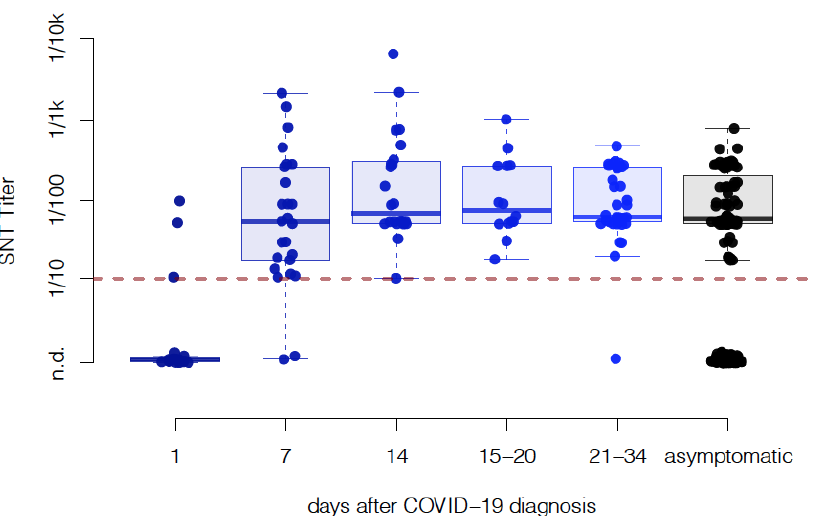
Figure 2. Serum neutralizing antibody titers of mildly symptomatic and asymptomatic individuals. Neutralizing titers of patients with non-severe COVID-19 and asymptomatically infected individuals were measured in quadruplicate and shown as the geometric mean titer (GMT). No statistically significant difference in titers was found between asymptomatic participants with a detectable titer and symptomatic patients at or after day 14 by the Wilcoxon rank sum test with continuity correction ( p = 0.77). Healthy volunteers who either tested positive for viral RNA in nasal swabs or had detectable nAbs were defined as asymptomatic. Each dot represents one individual. n.d. = not detectable.